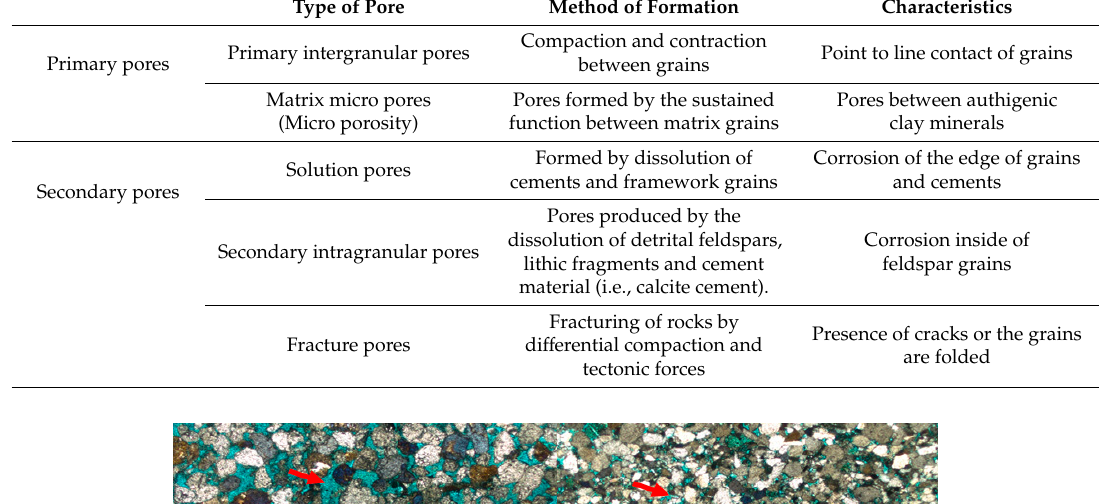
Table 7. Observed pores in the sandstones of the Bredasdorp Basin.